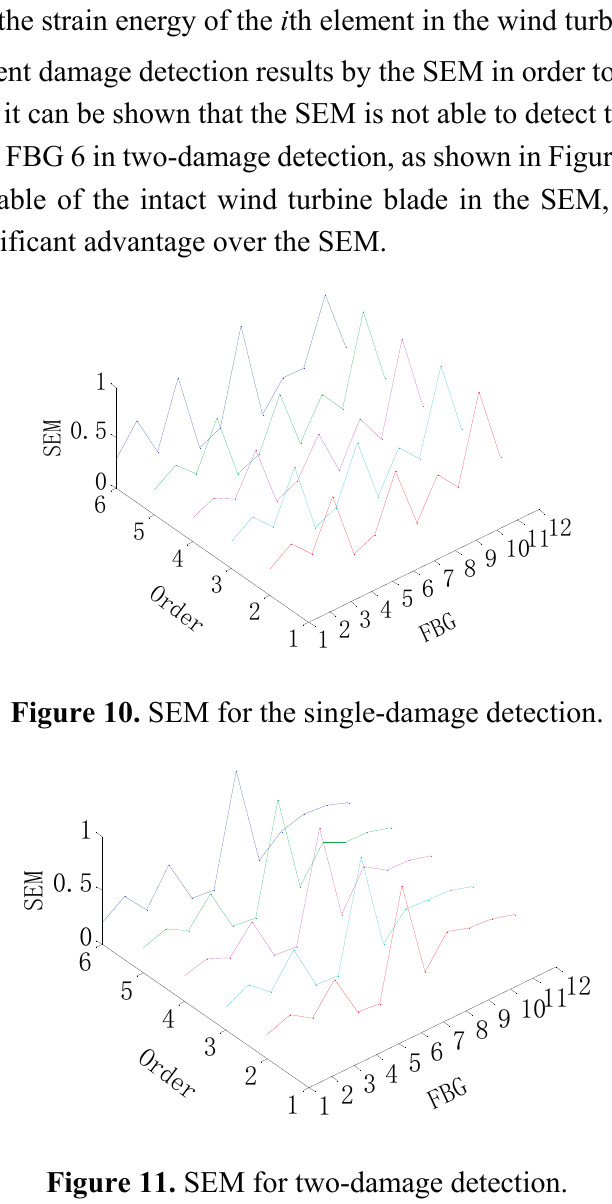
Figure 11. SEM for two-damage